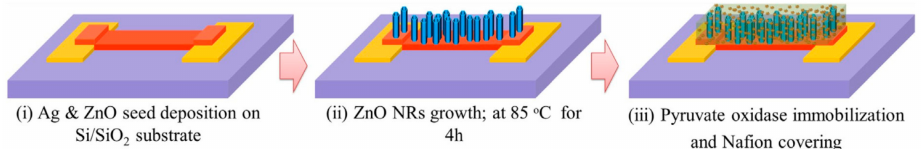
Figure 4. Fabrication process of ZnO-FET biosensors by the radio-frequency magnetron-sputtering method [69]. Reprinted from Journal of Colloid and Interface Science, 498, Ahmad et al., ZnO Nanorods Array Based Field-E ff ect Transistor Biosensor for Phosphate Detection, 292–297, Copyright 2017, with permission from